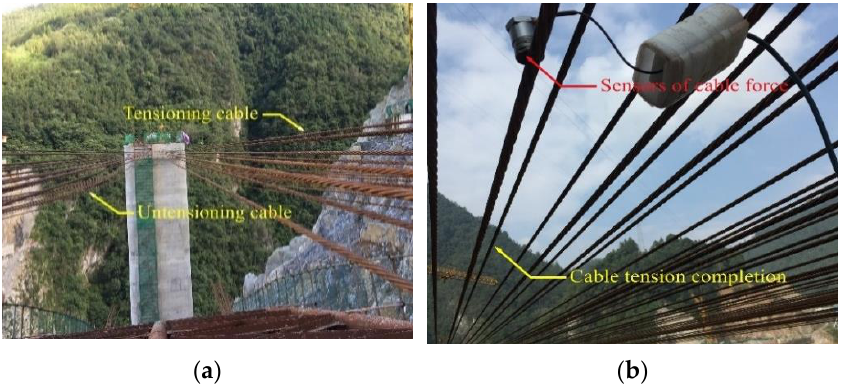
Figure 5. ( a ) Cable tension stage; ( b ) cable tension measurement.